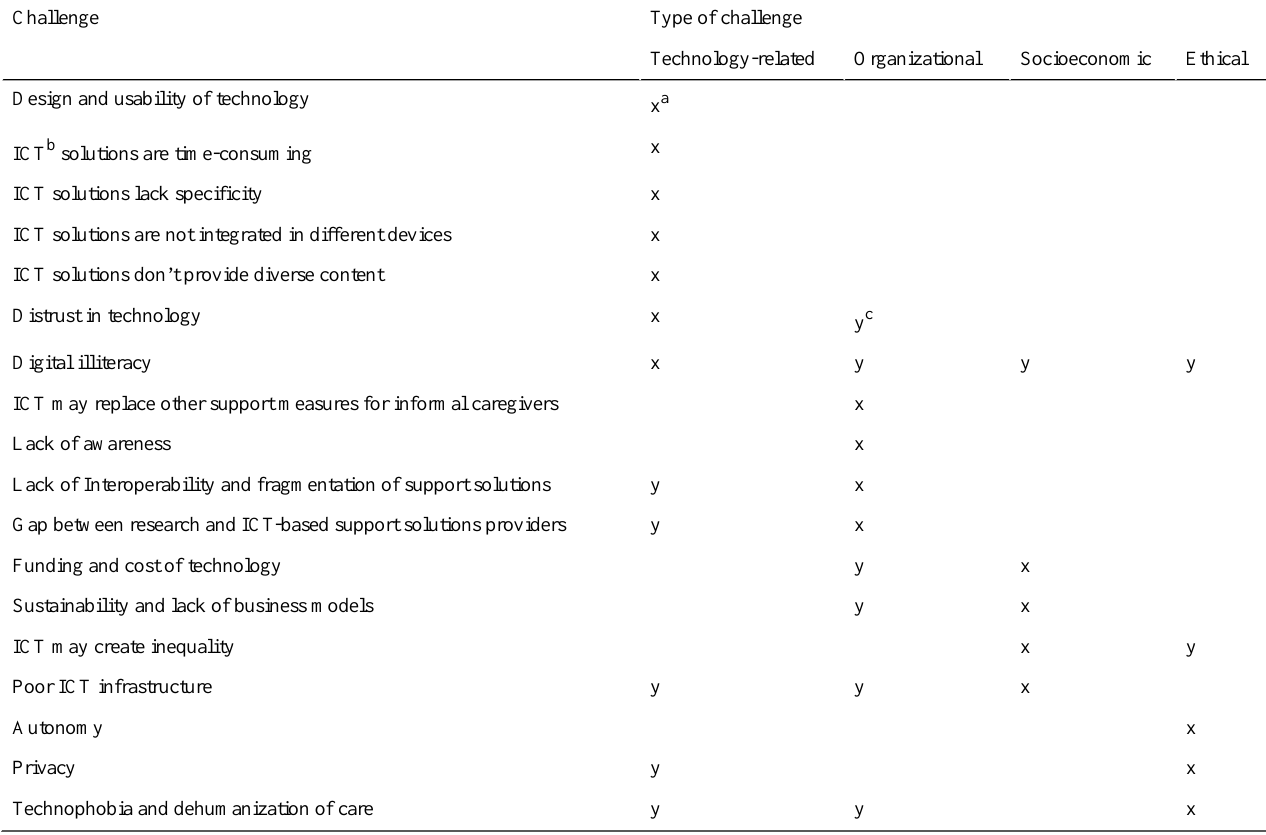
Table 3. Overview of the identified challenges with the prevailing theme and the possible co-themes for each challenge.